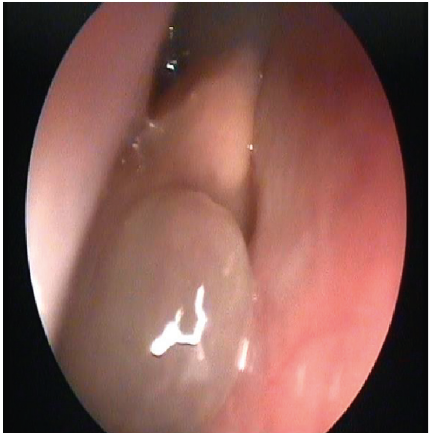
Figure 10: The intraoperative endoscopic spitting images illustrate various nasal polyps.